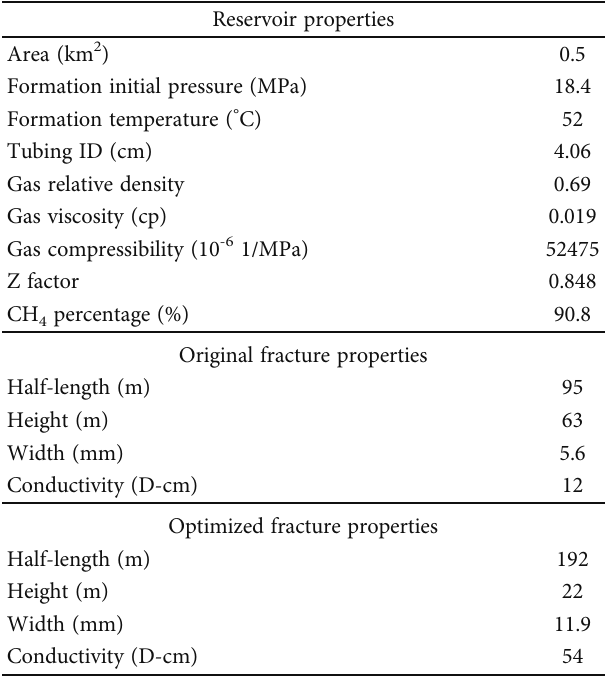
Table 6: Reservoir and fracture production simulation parameters of well